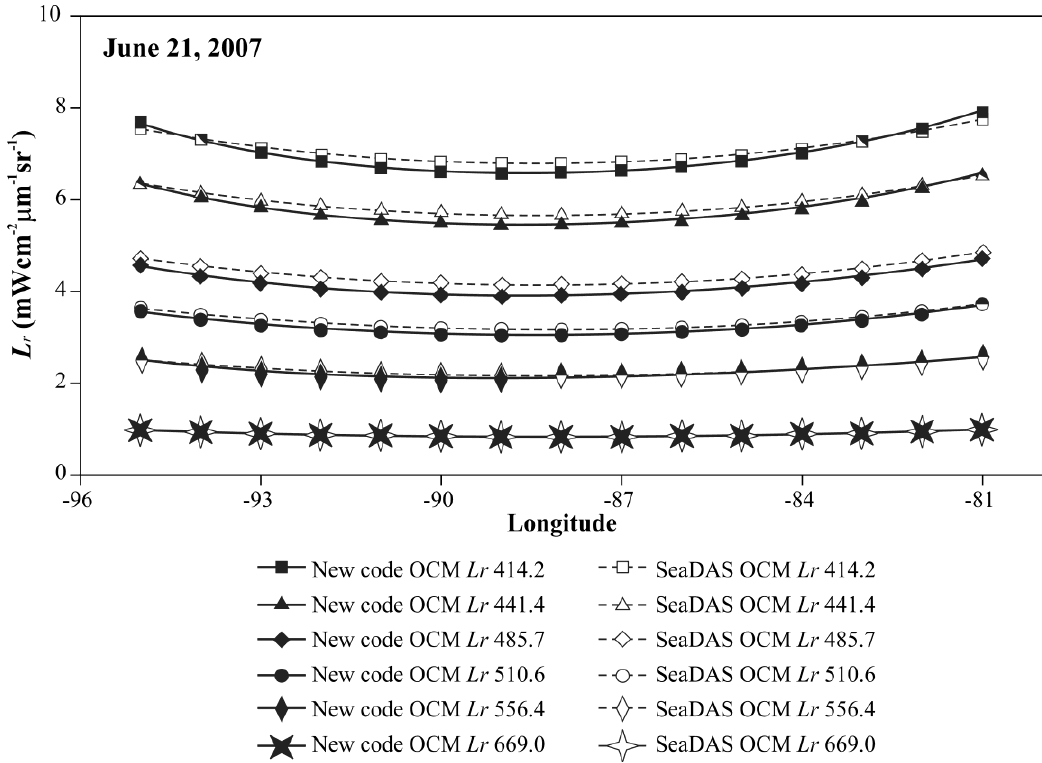
Figure 4. Comparison of Rayleigh path radiance for OCM bands 1–6 calculated by the new code and SeaDAS along a scan line of OCM data of 21 June 2007.